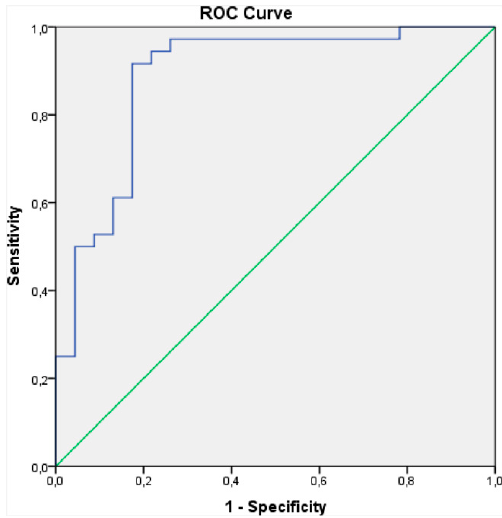
Figure 8. Data points from sensor measurements were used to construct a ROC-curve. Logistic regression showed a significant difference ( p < 0.05) in VOC resistance patterns between patients diagnosed with head and neck squamous cell carcinoma (HNSCC) and the control group, with a sensitivity of 90% and a specificity of 80%. HNSCC head and neck squamous cell carcinoma; ROC receiver operating characteristic; VOC volatile organic compounds. Commas in axis numbers represent decimal places. Used with permission from [81].